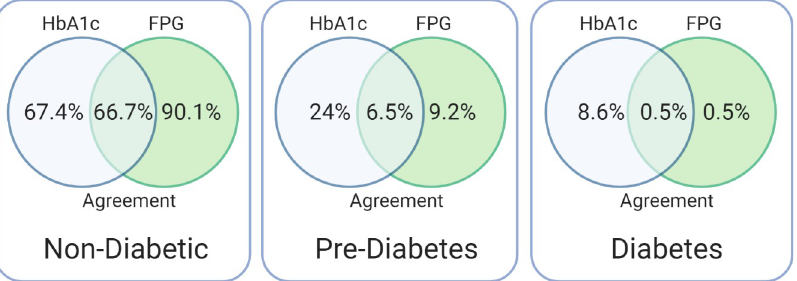
Fig 3. Diagnostic agreement between fasting plasma glucose and glycated hemoglobin. FPG: Fasting plasma glucose, HbA1c: Glycated hemoglobin.